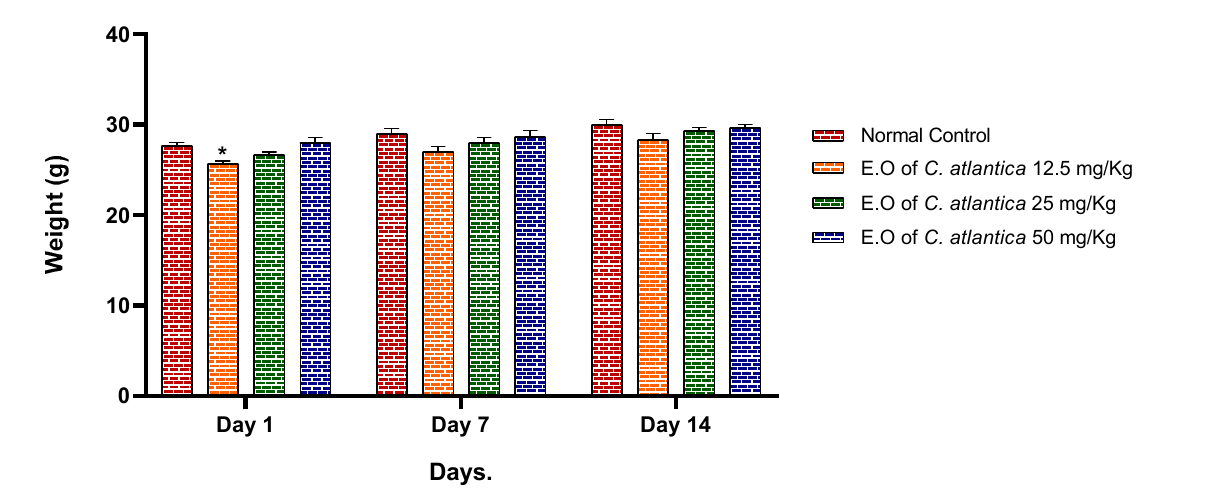
Figure 7. Bodyweight development of the mice. Values are expressed as mean ± SD ( n = 5). * p < 0.05. Table 3. Relative organ weights of the tested mice. Table 3 presented the relative organ weights of the control and dose-treated mice with 12.5, 25, and 50 mg/kg of C. Atlantica essential oil (CDEO) and sacrificed after 14 days of treatment. The results present are not significant when comparing it to the normal con- trol, indicating no toxicity towards those organs.